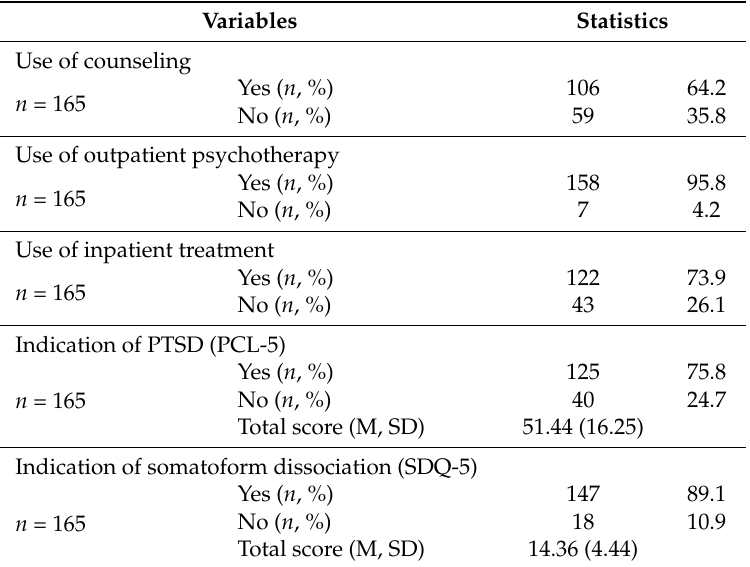
Table 3. Clinical sample characteristics of self-identified ORA victims ( n = 165).